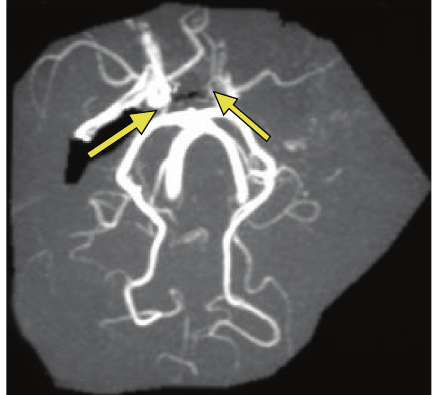
Figure 6: Intracranial MRA showing recanalisation of the right ICA; the right and left MCAs are visible as well as both posterior communicating arteries